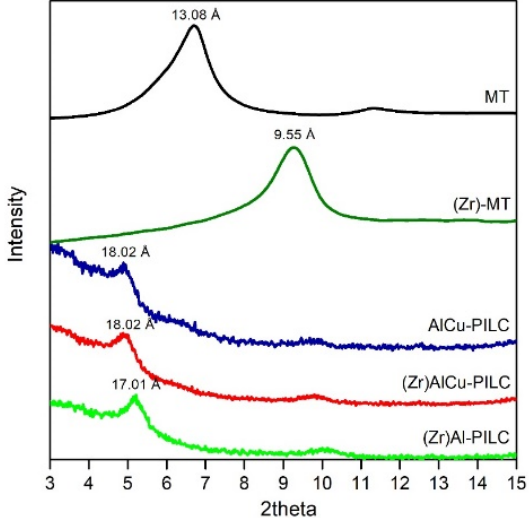
Figure 1. X-ray diffraction results obtained before (MT) and after the pillaring process (AlCu-PILC) and Zr-dopage ((Zr)-Al-PILC,